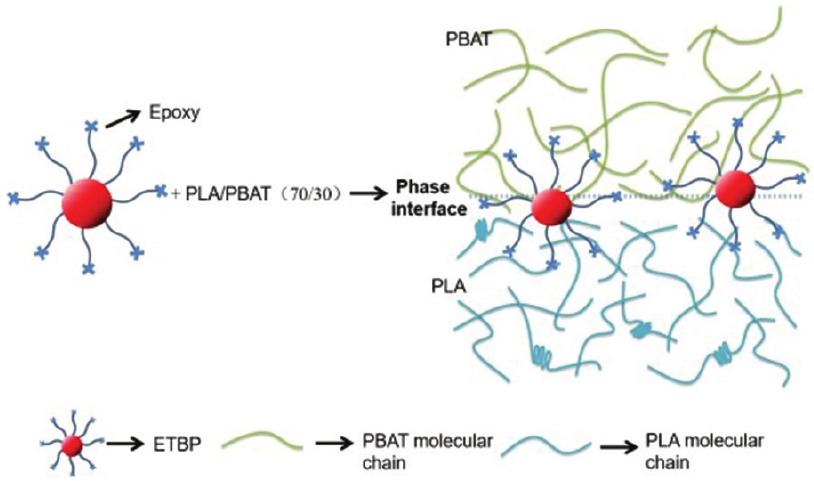
Figure 4: Proposed modification mechanism of ETBP on the PLA/PBAT